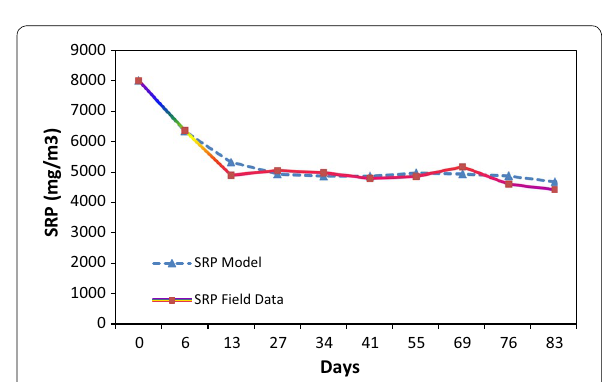
Fig. 6 Comparison of modeled results of soluble reactive phosphorus and measured data (mg/m 3 ) during 83